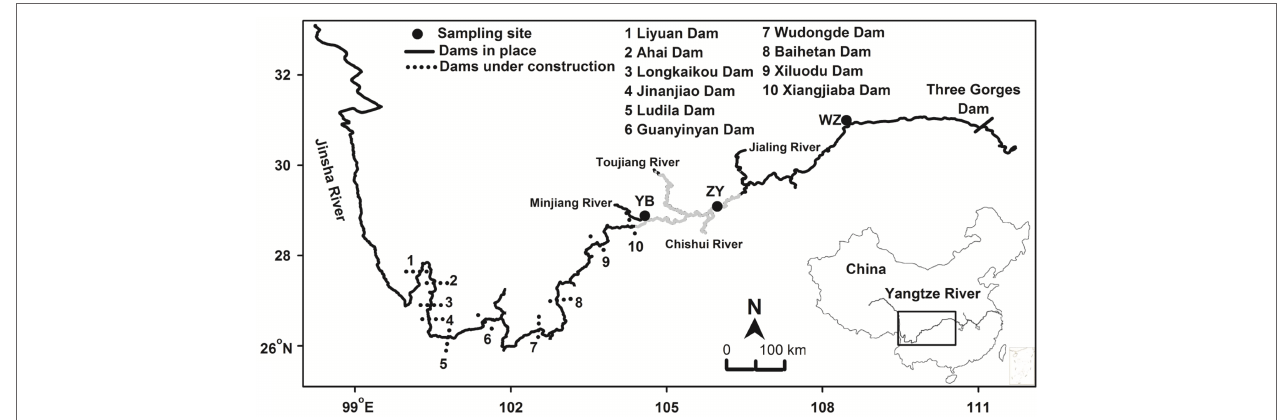
FIGURE 1 | Sampling sites of Procypris rabaudi for the wild population (ZY), Yibin hatchery (YB), and Wanzhou hatchery (WZ) in the upper Yangtze River. Main section of the National Natural Reserve Areas of Rare and Special Fishes of the Upper Yangtze River is shown using gray, and main tributaries, the Three Gorges Dam, and 10 cascade dams in the middle and lower reaches of the Jinsha River are